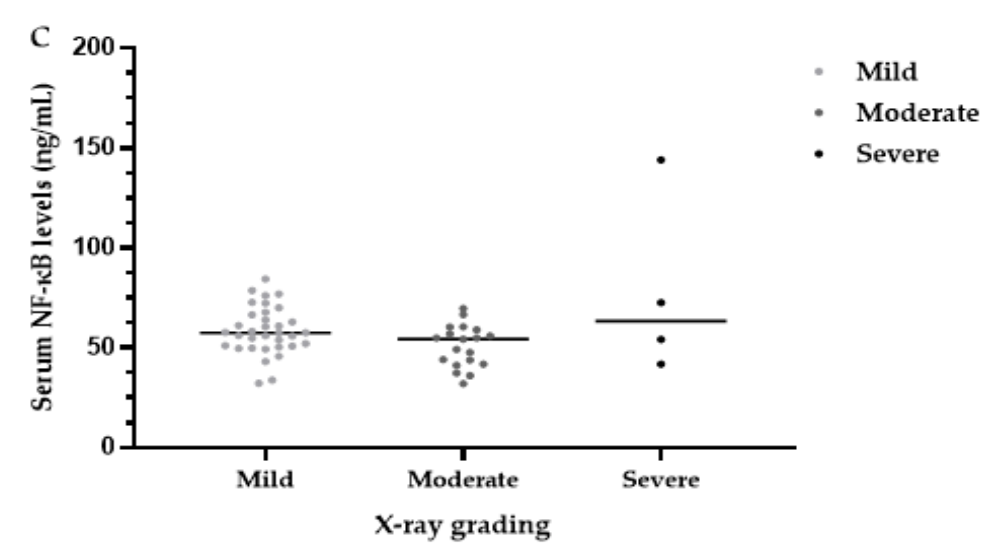
Figure 8. ( a ) Analysis of serum NF- κ B levels in the SF group and control group; ( b ) Analysis of NF- κ B levels in the SF group by sex and age; ( c ) Analysis of NF- κ B levels in the SF group by X-ray diagnostic grade. * p < 0.05 compared to the control group. NF- κ B: nuclear factor- κ B. There were no significant differences in serum levels of NF- κ B between males (57.25 ng/mL) and females (54.85 ng/mL) within the SF group ( Z = 0.75, p > 0.05). Within the SF group, the median serum MCP-1 levels were not significantly different between the ~60-year-old group (57.38 ng/mL) and the ~80-year-old group (55.37 ng/mL) SF ( Z = 0.85, p > 0.05) (Table 4, Figure 8b). Within the SF group, the median serum SDF-1 levels were not significantly different among patients with mild (57.58 ng/mL), moderate (54.55 ng/mL) and severe (63.30 ng/mL) SF ( H = 4.46, p > 0.05) (Table 4, Figure